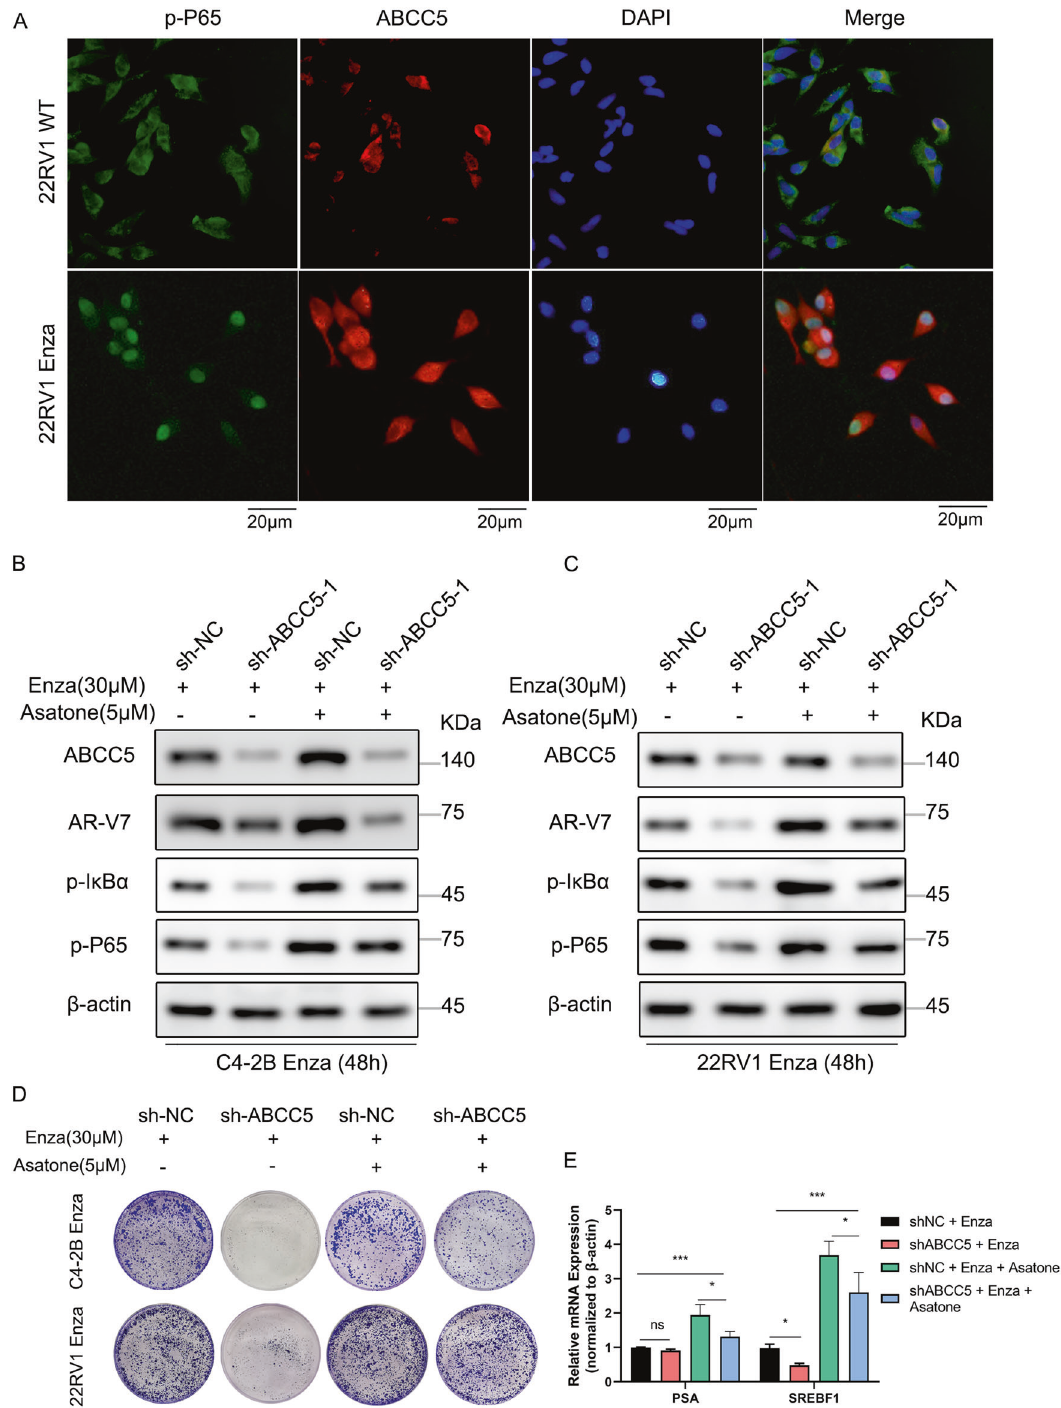
Fig. 6 NF- κ B agonist Asatone rescues the function of promoting enzalutamide resistance in ABCC5-knockdown cells. A Representative images of confocal microscopy immuno fl uorescence staining for ABCC5 and p-P65 co-localization in 22RV1 WT and 22RV1 Enza cells. Scale bars, 20 μ m. The levels of ABCC5, AR-V7, phosphorylated IKB α , and phosphorylated P65 were detected by Western blotting in ABCC5-knockdown and control C4-2B Enza ( B ) and 22RV1 Enza ( C ) cells combined with or without Asatone (5 µM) in enzalutamide treatment. D ABCC5-knockdown and control C4-2B Enza and 22RV1 Enza cells with or without Asatone in enzalutamide treatment for colony formation assays construction. E Relative mRNA expression of AR and AR-V7 target genes (PSA, and SREBF1) were analyzed by qRT-PCR under the condition of C4-2B shNC and shABCC5 cells treated with or without 5 μ M Asatone accompanied by 30 μ M enzalutamide for 48 h. * P < 0.05, *** P < 0.001, n.s., not signi fi cant. Human tissue samples were obtained with the written consent of patients who underwent radical In total, 80 paraf fi n-embedded samples from 17 patients with benign prostatectomy or transurethral resection prostate (TURP) at Xinhua prostatic hyperplasia (BPH) patients, 57 with primary PCa, and 6 with CRPC Hospital af fi liated to the Shanghai Jiao Tong University School of Medicine. Cell Death Discovery (2022)